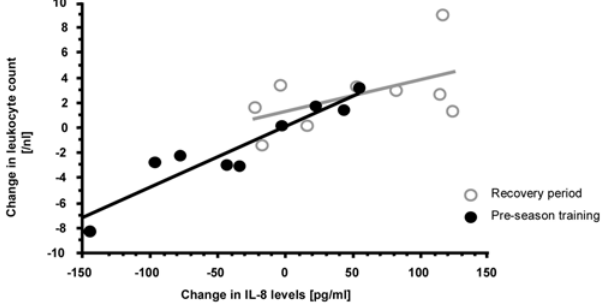
Figure 4. A significant correlation between IL-8 levels and leukocyte count demonstrated a recovery from stress-related leukopenia from the playing season to the recuperation phase, as well as a return to lower leukocyte counts after the stressfull phase of pre-season training.